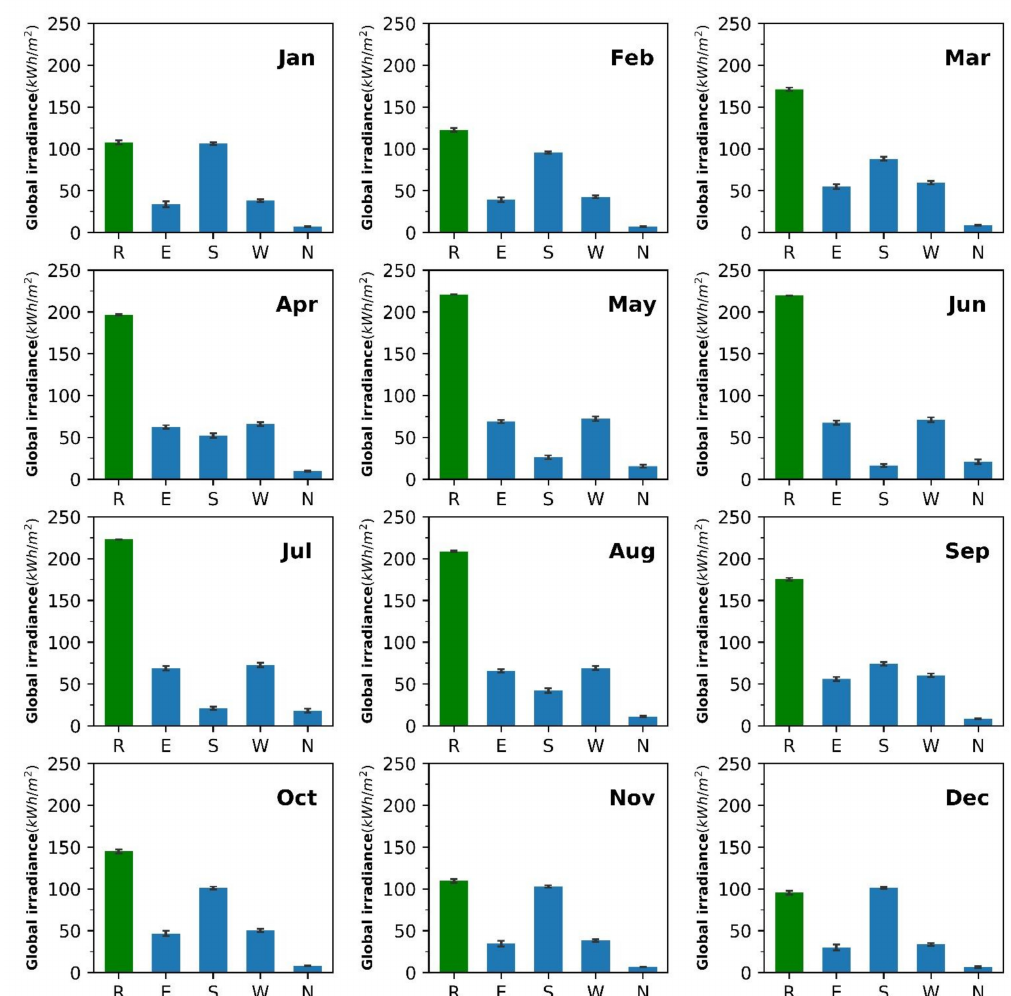
Figure 18. Variation of the monthly solar radiation on the roof and four